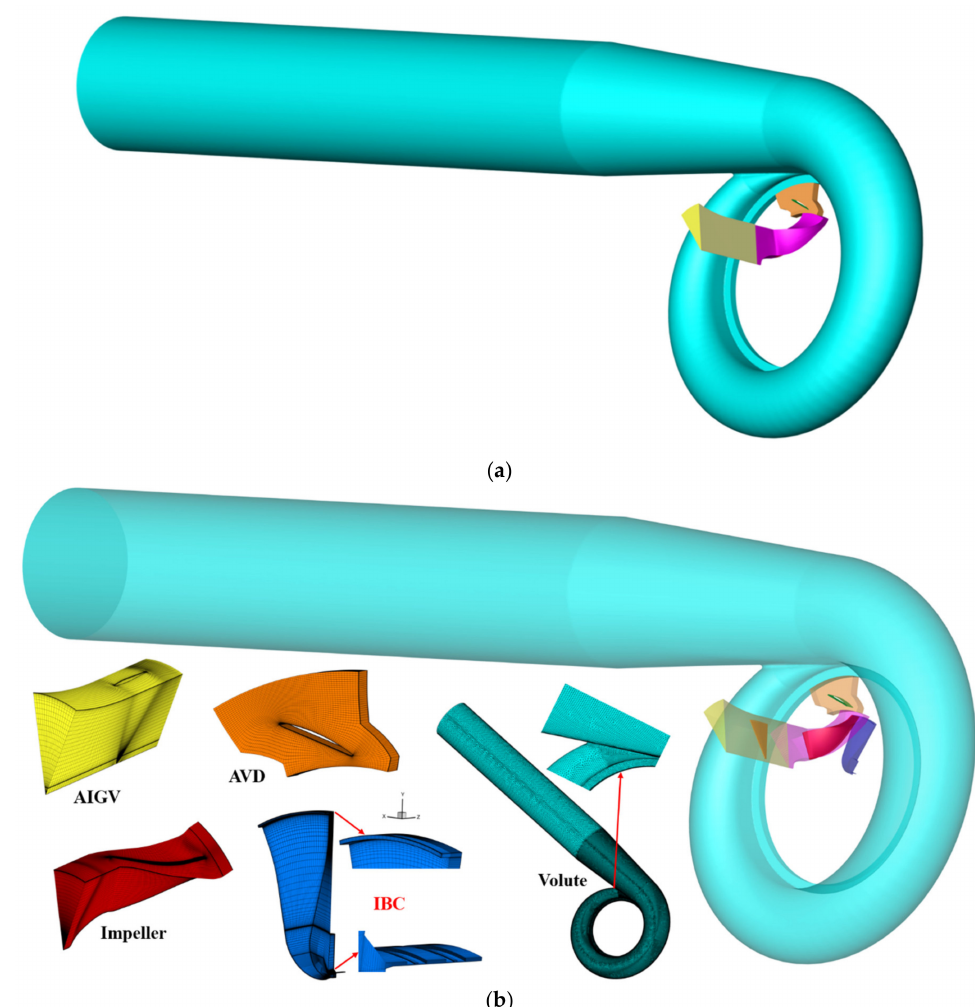
Figure 3. Two groups of computational domains: ( a ) all mainstream domains without IBC; ( b ) all mainstream domains with IBC.